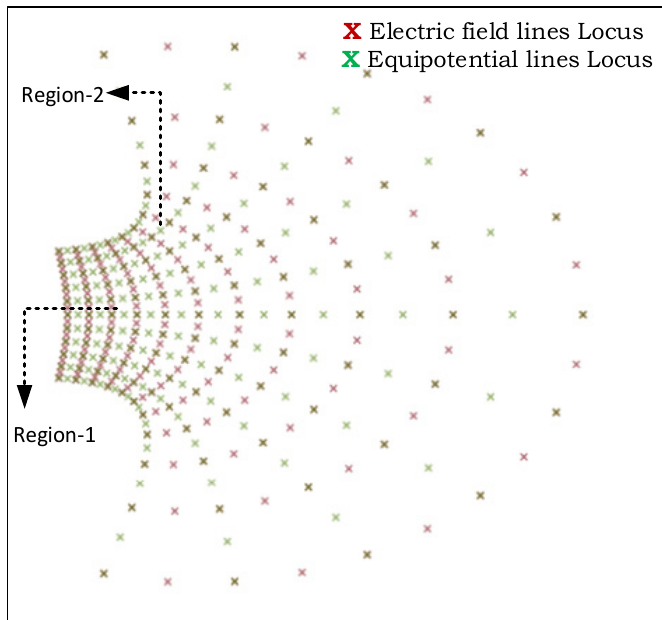
Figure 4. Conformal mapping of Rogowski profile for A = π .